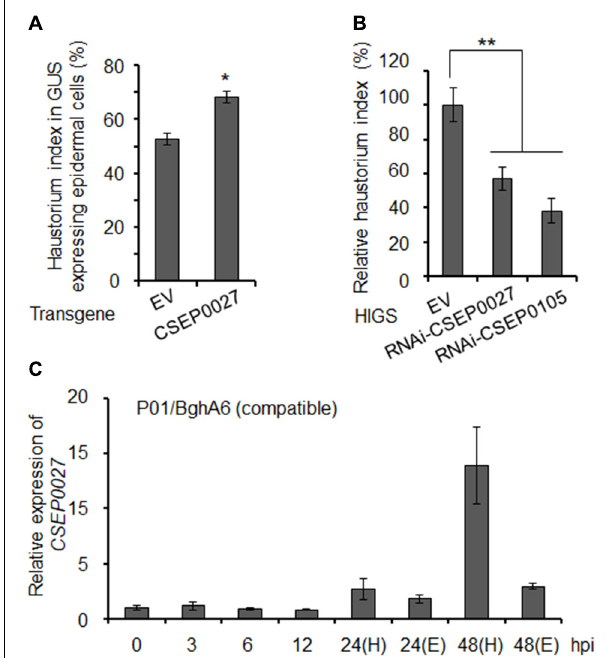
FIGURE 3 | CSEP0027 contributes to Bgh virulence. (A) Overexpression of CSEP0027 promotes Bgh haustorial formation rate. One-week-old barley leaves (P01) were bombarded with EV or CSEP0027 construct plus GUS reporter construct, and inoculated with compatible isolate BghA6 . Bgh haustorium was microscopically scored, and haustorium index (HI%) was calculated as the number of cells containing haustorium in glucuronidase (GUS) expression cells divided by the total number of GUS expression cells with germinated Bgh spores and an attached appressorium. Data show the average values and SD are from three representative experiments. (B) Silencing of CSEP0027 by host induced gene silencing (HIGS) reduces Bgh haustorial formation rate. One-week-old barley leaves (P01) were bombarded with indicated construct plus GUS reporter construct. The bombarded leaves were inoculated with the virulent isolate BghA6 at 48 h after bombardment. Bgh haustorium index was microscopically scored at 48 hpi, and the relative Bgh haustorium index in silencing experiment was standardized to EV (pIKP007) control, which was arbitrarily set to 100%. Data show the average values and SD from three representative replicates. RNAi-CSEP0105 is used as a positive control. * p < 0.05 and ** p < 0.01; show significant difference by Student’s t test. (C) Expression pattern of CSEP0027 at early stages of Bgh infection. The barley P01 was inoculated with the virulent isolate BghA6 . Total RNA was isolated from Bgh -infected barley leaves at 0, 3, 6, 12, 24, and 48 hpi for quantitative real-time PCR (qRT-PCR) analysis. H denotes leaf samples containing haustorium, and E denotes epiphytic Bgh tissues removed from the leaf surface. Relative expression was determined by comparing with time point 0 hpi, arbitrarily set to 1. Bgh glyceraldehyde 3-phosphate dehydrogenase was used as the reference gene. Error bars indicate SD of three replicates. The experiments were repeated two times with similar